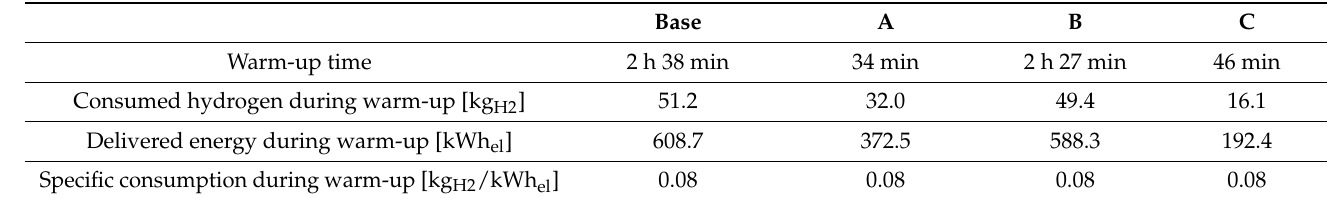
Table 4. Warm-up simulations: warm-up time, amount of hydrogen consumed, delivered electric energy generated and average specific hydrogen consumption during warm-up, for the base case and for cases A, B, and C of the sensitivity analysis.